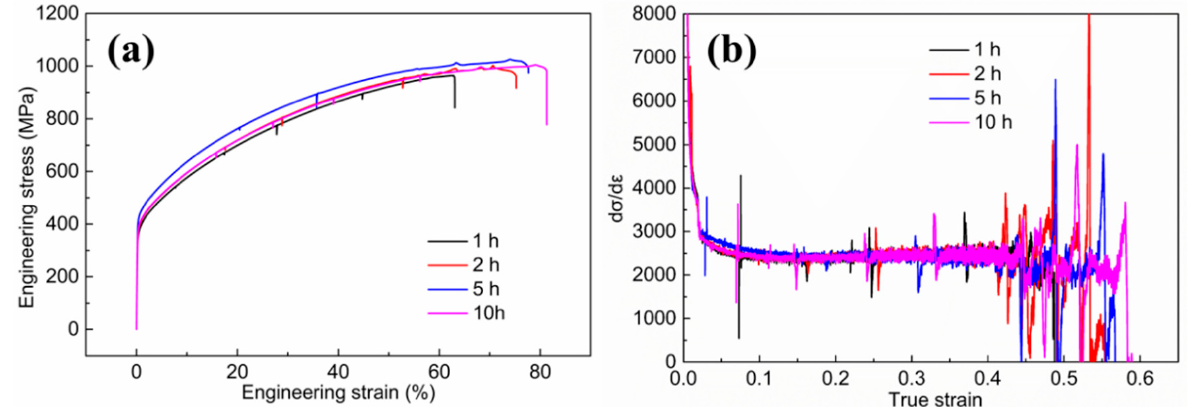
Figure 6. Mechanical properties of the tested alloy demonstrated in terms of the engineering stress–strain curves ( a ) and the corresponding work hardening curves with respect to true strain ( b ).